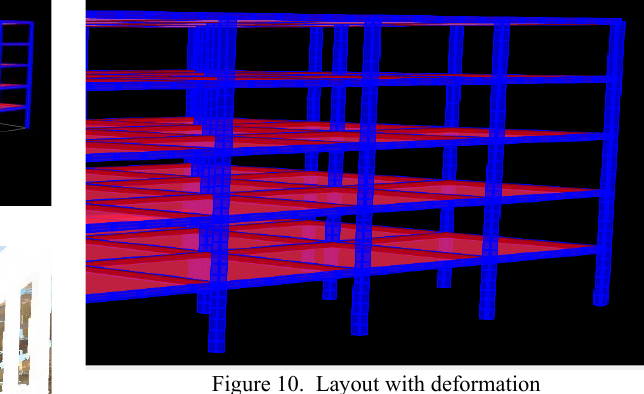
Figure 10. Layout with deformation